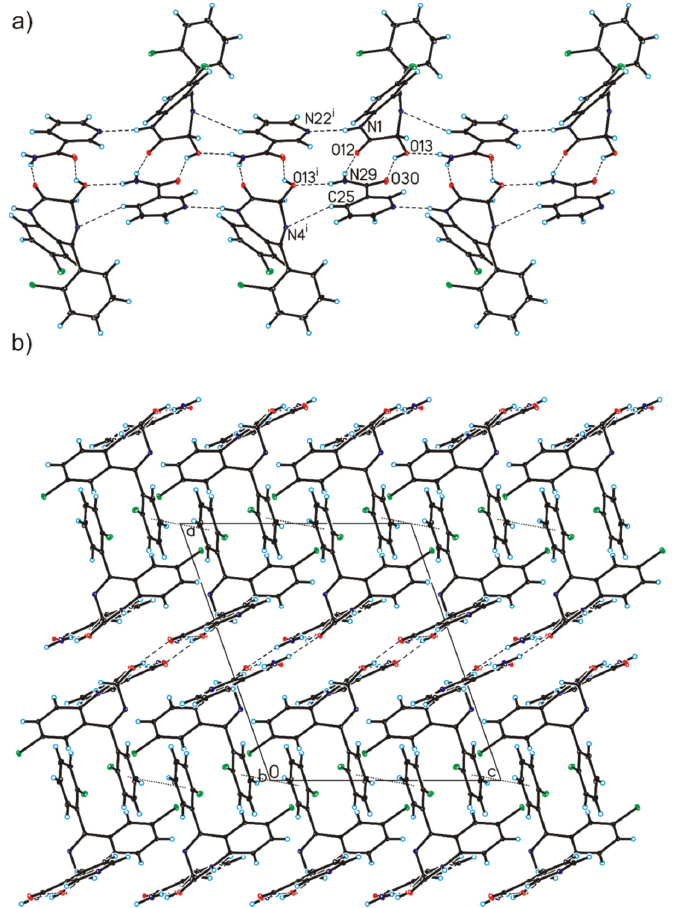
Figure 8. ( a ) Tapes formed by lorazepam and nicotinamide molecules in the co-crystals. ( b ) Crystal packing of lorazepam co-crystals with nicotinamide viewed along the b -axis (hydrogen bonds are represented by dashed lines, whereas π ··· π interactions by dotted lines; disordered chlorobenzene ring was omitted for clarity; symmetry codes: (i) 1 − x, ½+y, ½ − z.